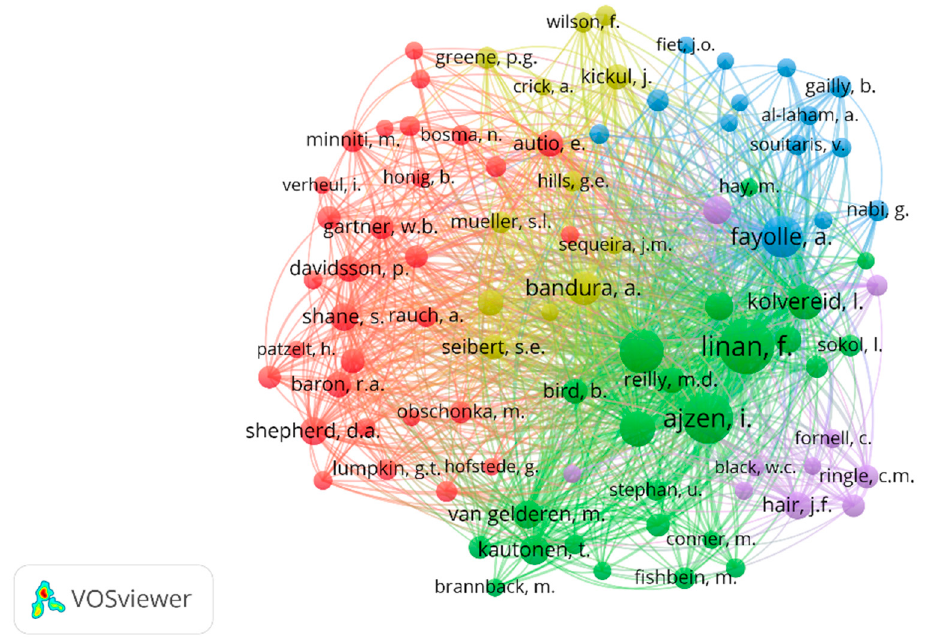
Figure 3. Co-citation visualization (entrepreneurial intention—SCOPUS). Cluster 1 (Red), Cluster 2 (Green), Cluster 3 (Blue), Cluster 4 (Yellow), Cluster 5 (Violet).